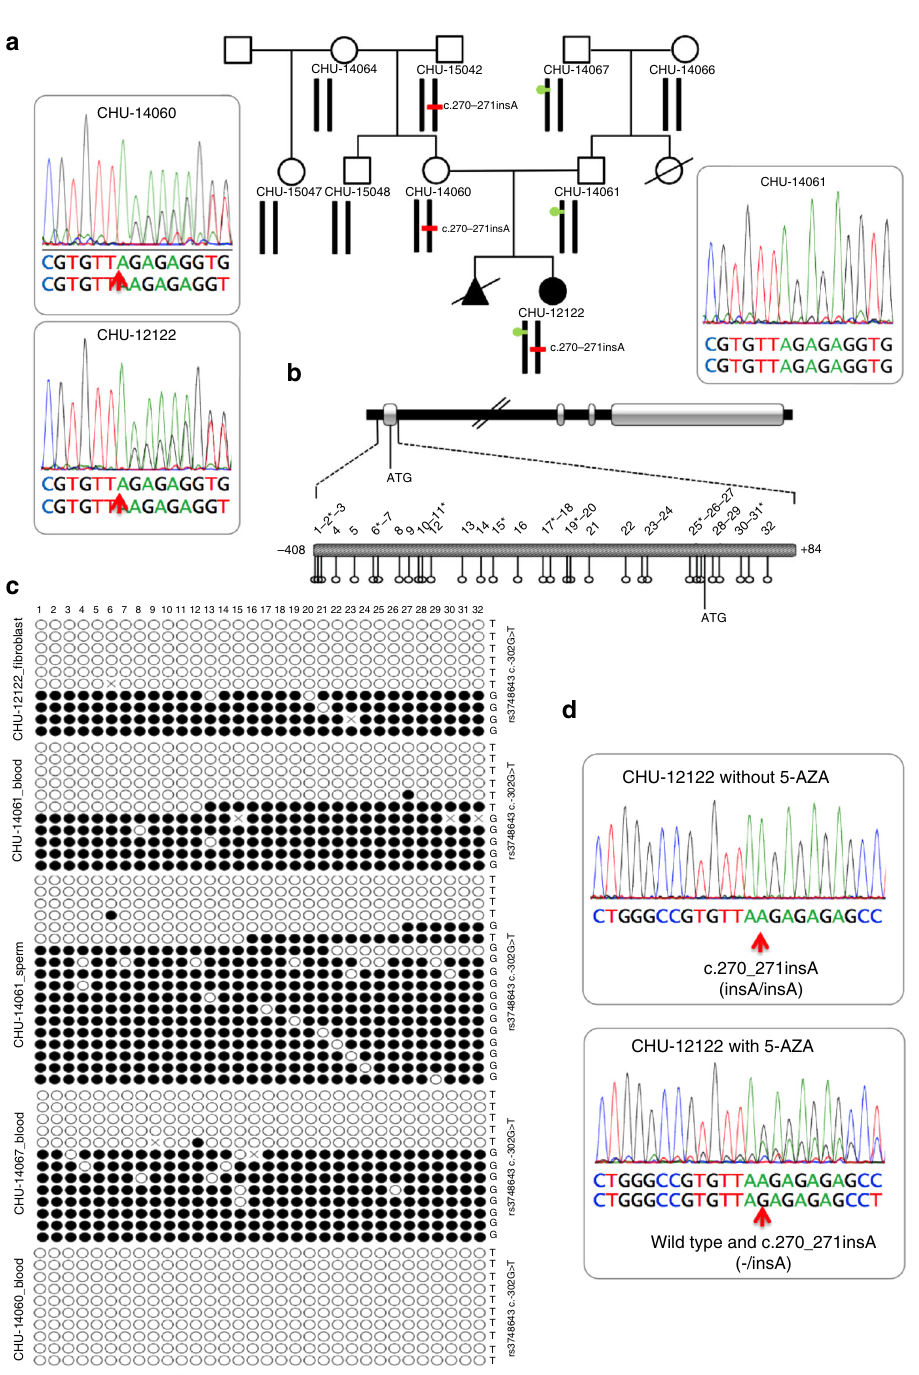
Fig. 1 The CHU-12122 epi- cblC case is compound heterozygous for a coding mutation and an epimutation of MMACHC detected in three generations. a Pedigree of the family of case CHU-12122; red bar, mutation (heterozygous c.270_271insA, p.Arg91LysfsTer14) found in the proband, her mother, and her maternal grandfather; green circle, epimutation encompassing the MMACHC promotor/exon 1 found in the proband. b Map of the MMACHC gene and expanded view of the MMACHC CpG island. CpG sites are numbered according to their position upstream and downstream of ATG. Asterisks indicate the CpG sites of the CpG island which were probed in the HM450K array. c Epigrams of MMACHC methylation analyzed by PCR ampli fi cation/cloning/Sanger sequencing of bisul fi te-treated DNA. Epimutations were detected in the proband, her father, and her paternal grandfather. d RT-PCR of fi broblasts from case CHU-12122 before and after the 3-day treatment with 10 µ M 5-azacytidine (5-AZA). Silencing of the wild-type allele (mono-allelic expression in upper panel, red arrow) was reversed after treatment (bi-allelic expression after treatment, lower panel, red